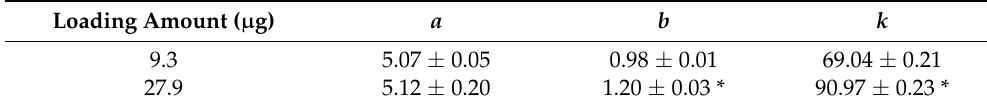
Table 3. Weibull equation constants derived from Figure 10b.